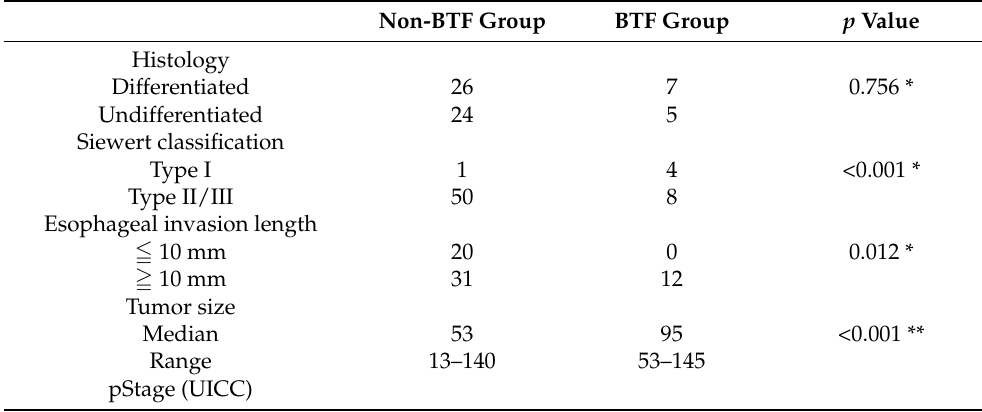
Table 3. Pathological